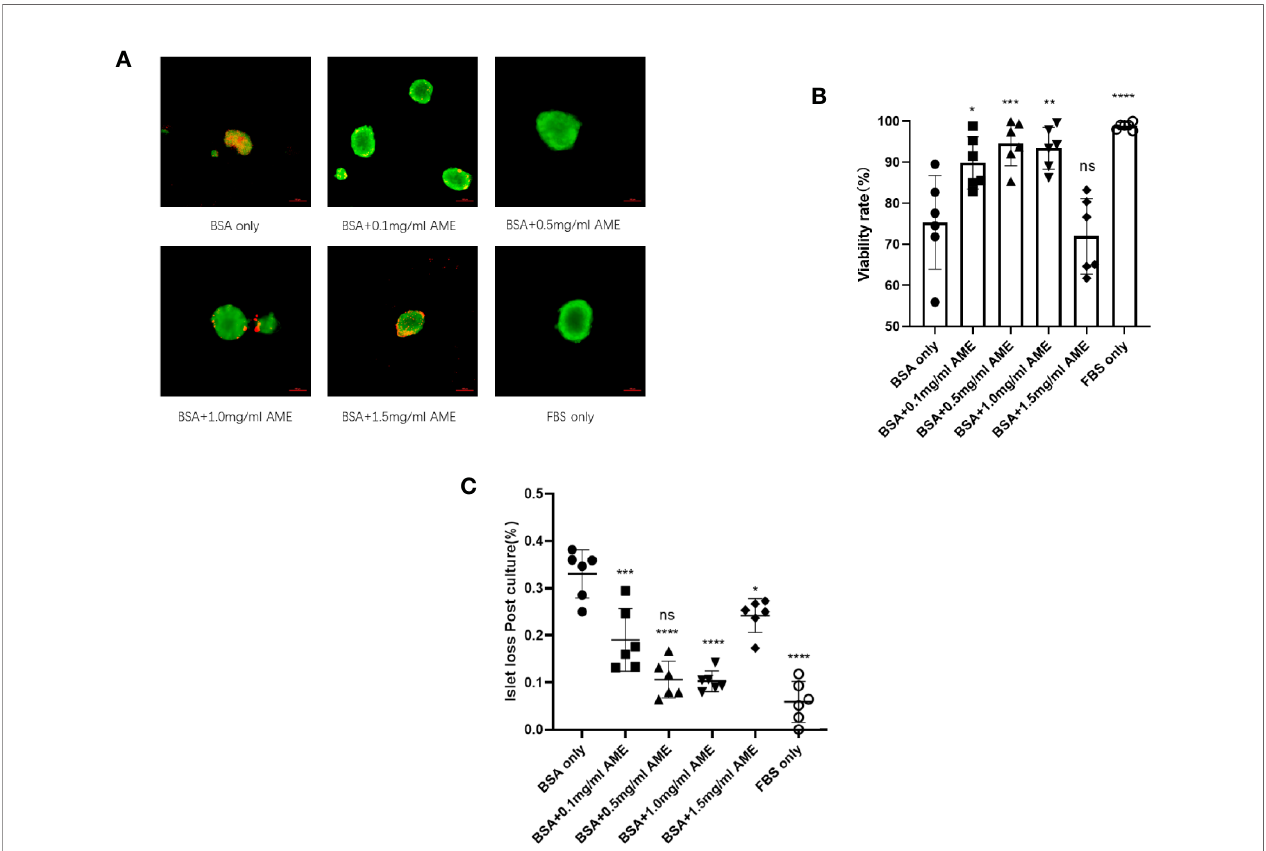
FIGURE 1 | AME signi fi cantly increased the viability and recovery of serum-deprived islets (A) . Representative images are showing AO/EB staining of isolated islets after 48 h cultivation. Viable cells are stained as green (B) . The percentage of viable cells was signi fi cantly increased with AME treatment (*p < 0.05, **p < 0.01, ***p < 0.001, ****p < 0.0001 and ns vs. BSA only group, One-way ANOVA). Results are shown as means ± SD of six independent experiments, with 75 – 100 islets/ condition for each independent experiment. Scale bar: 100 m m (C) . The percentage of islet loss post 48-h cultivation in vitro (***p < 0.001, ****p < 0.0001, ****p < 0.0001, *p < 0.05, and ****p < 0.0001 vs. BSA only group, and ns vs. FBS only group, One-way ANOVA). Results are shown as means ± SD of six independent experiments, with 75 – 100 islets/condition for each independent